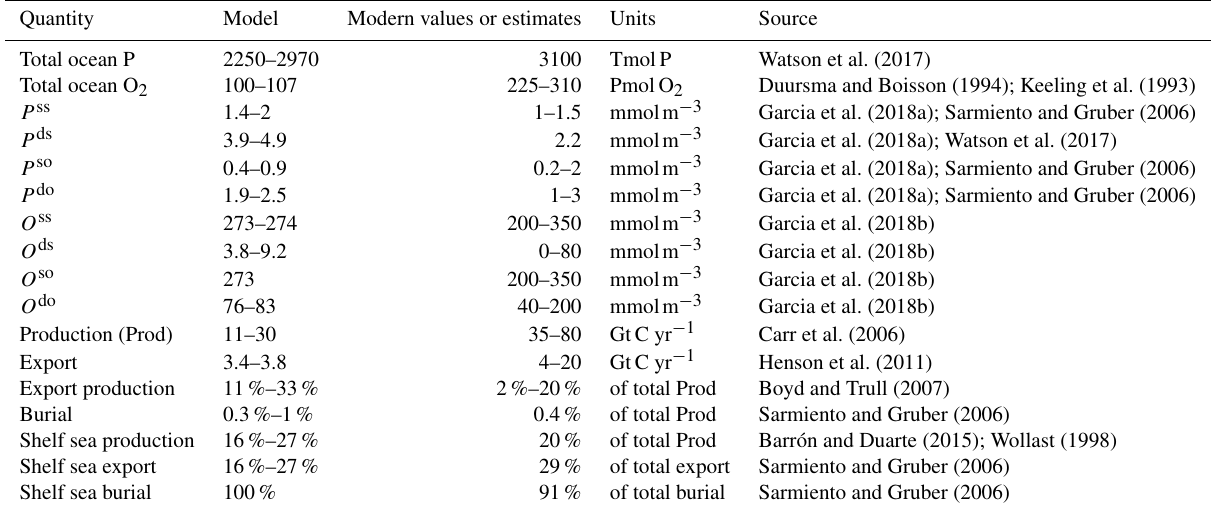
Table 5. Summary of the model evaluation provided in Sect. 3. Modern observations and estimates are compared to model results obtained for z remL in the range of measured values for a modern shelf sea (Cavan et al.,